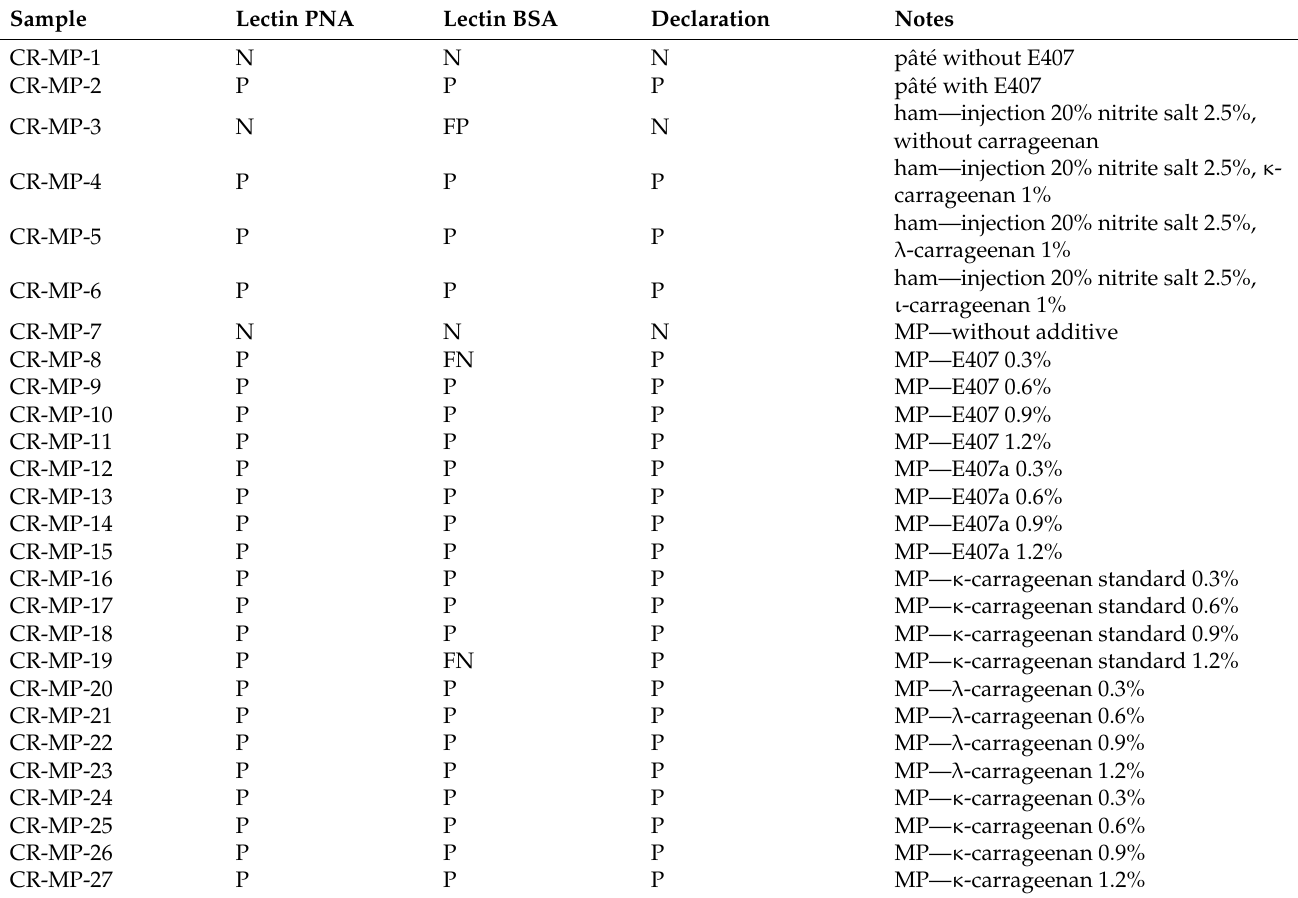
Table 5. Results of cross-reactivity for model